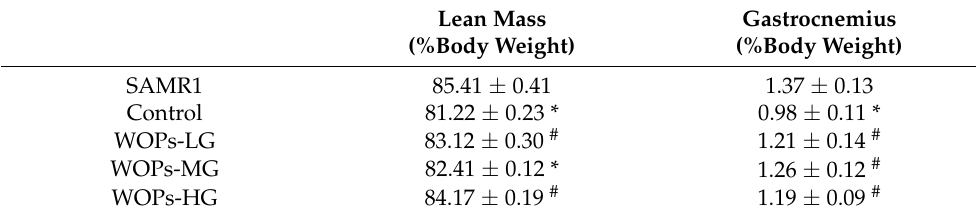
Table 1. Body composition and gastrocnemius tissue mass in